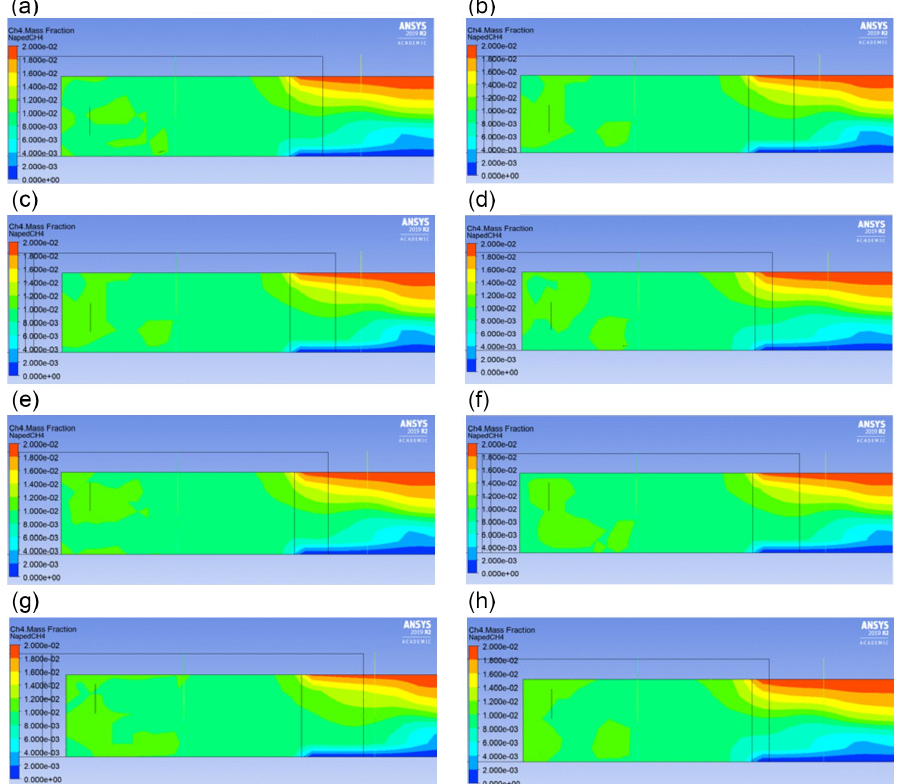
Figure 8. Result plane of methane concentration distribution at the line of conveyor drive location (AA (cid:48) ): ( a ) configuration M_9; ( b ) M_10 configuration; ( c ) configuration M_11; ( d ) configuration M_12; ( e ) configuration of M_13; ( f ) configuration M_14; ( g ) configuration M_15; ( h ) configuration